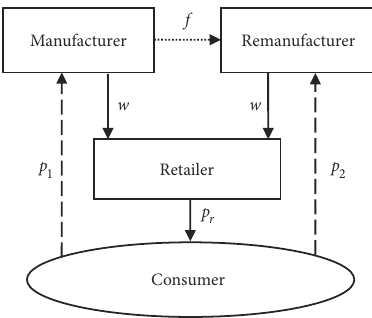
Figure 1. Structure model of the